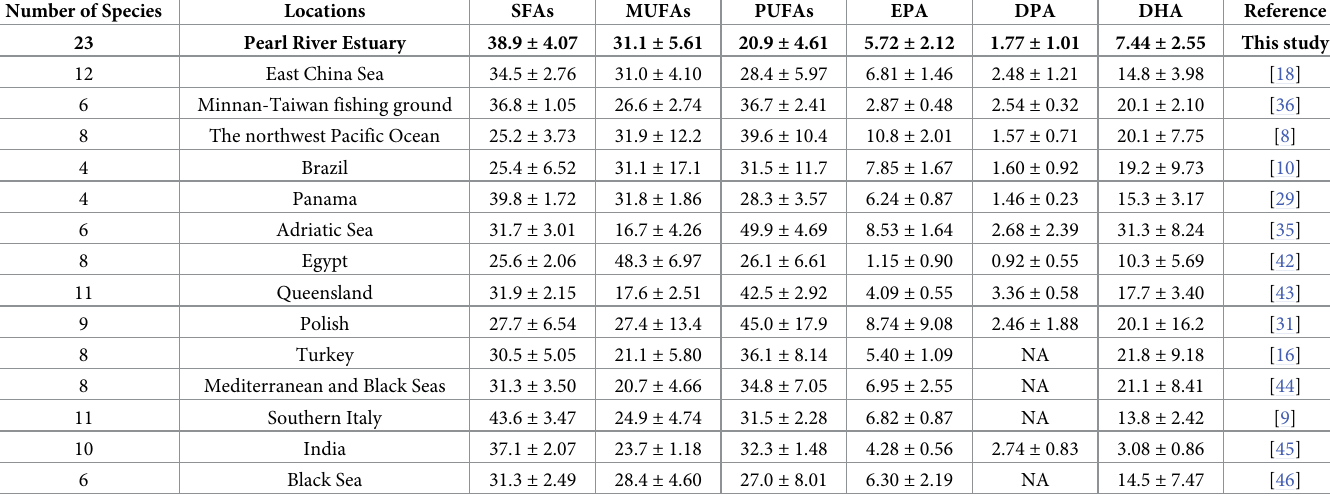
Table 3. Comparison of fatty acid profiles in marine fish species from different regions around the